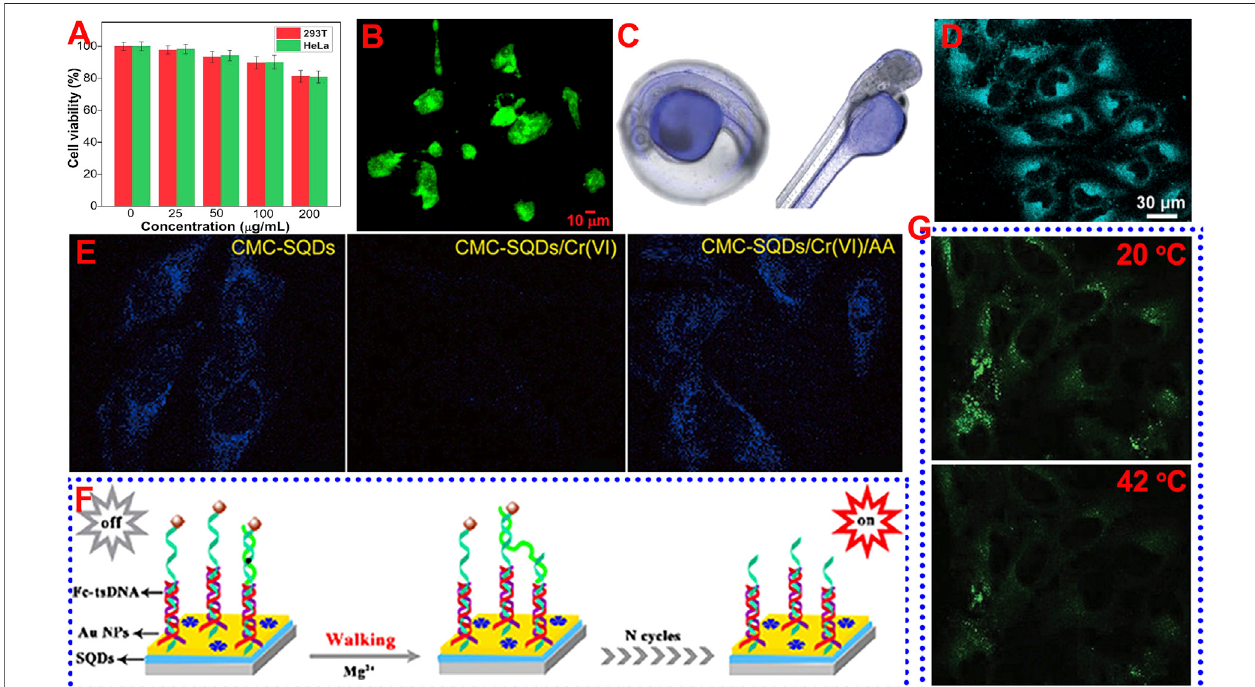
FIGURE 2 | Schematic diagram of the application of SQDs in bioimaging and biosensing. (A) Reproduced, with permission, from Duan et al. (2020). Copyright 2020, Elsevier. (B) Reproduced, with permission, from Arshad et al. (2021). Copyright 2021, American Chemical Society. (C) Reproduced, with permission, from Xia et al. (2021). Copyright 2021, Royal Society of Chemistry. (D) Reproduced, with permission, from Gao et al. (2022). Copyright 2022, American Chemical Society. (E) Reproduced,withpermission,fromDuanetal.(2020).Copyright2020,Elsevier. (F) Reproduced,withpermission,fromLiuetal.(2020).Copyright2020,American Chemical Society. (G) Reproduced, with permission, from Lei et al. (2021). Copyright 2021,